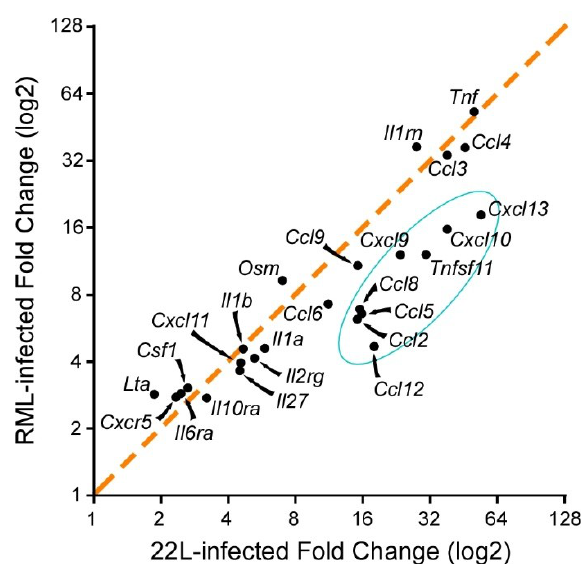
Figure 2. Comparison of the top 25 proinflammatory genes that are upregulated in the brain of clinical mice when infected with prion strains RML and 22L. The orange dashed line represents a one-to-one correlation in fold change of gene expression. Most of the changes are similar, thus close to the orange dotted line. There is a cluster of eight proinflammatory genes, blue circle, that are more highly altered with 22L infection, but the overall inflammation is comparable during the clinical phase of the disease regardless of prion